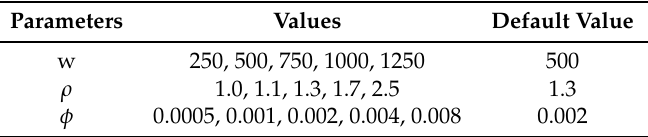
Table 2. Parameter values.